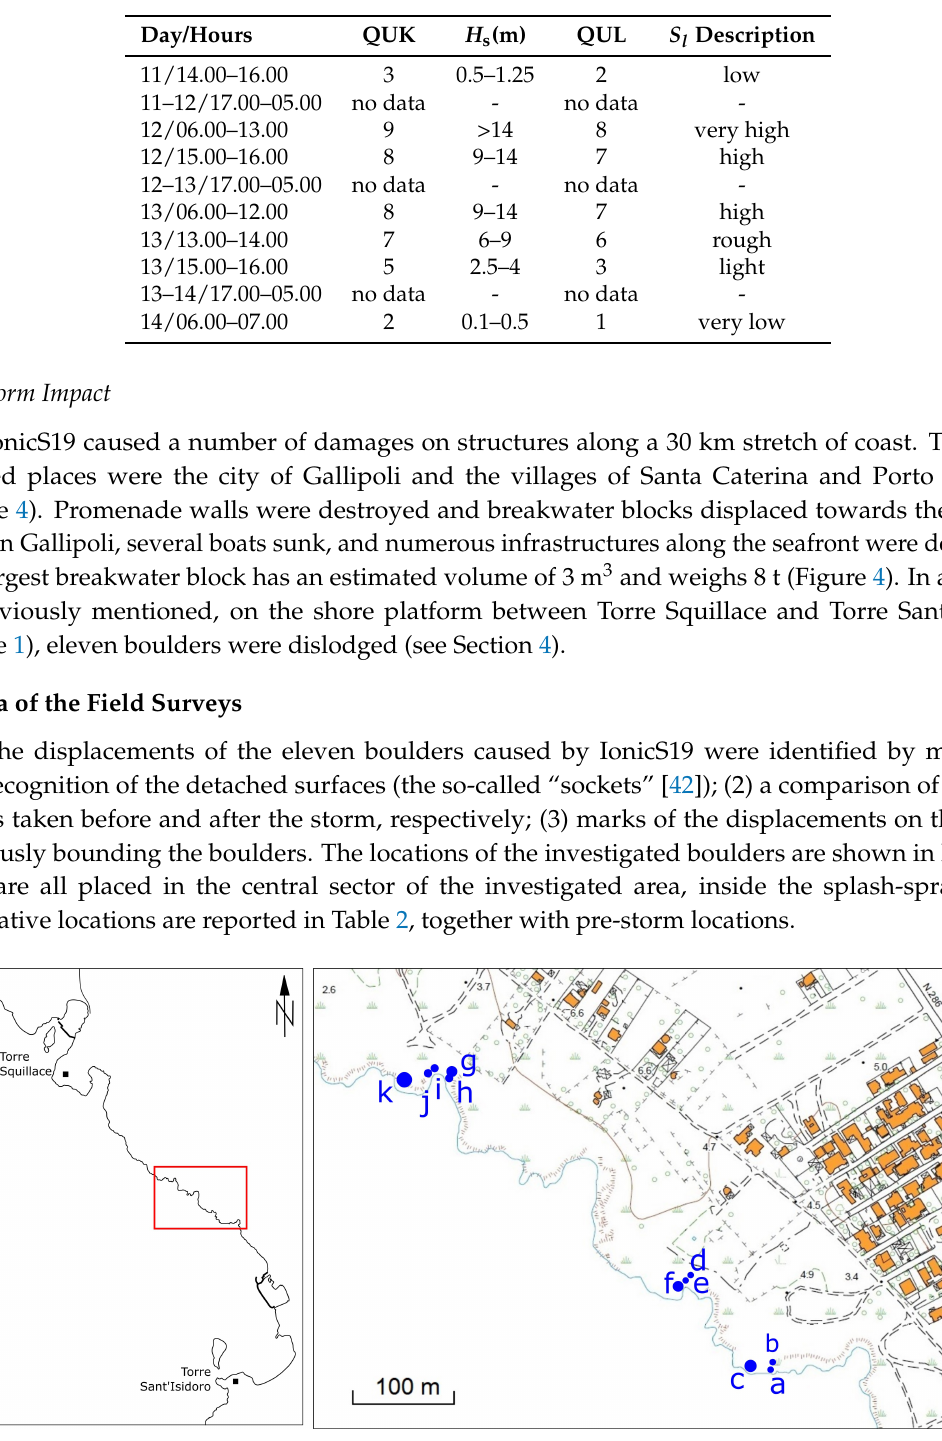
Table 1. QUK and QUL signals recorded hourly by the LIBY station in November 2019; data downloaded 11 December 2019 from the OGIMET site [37] (UTC time).